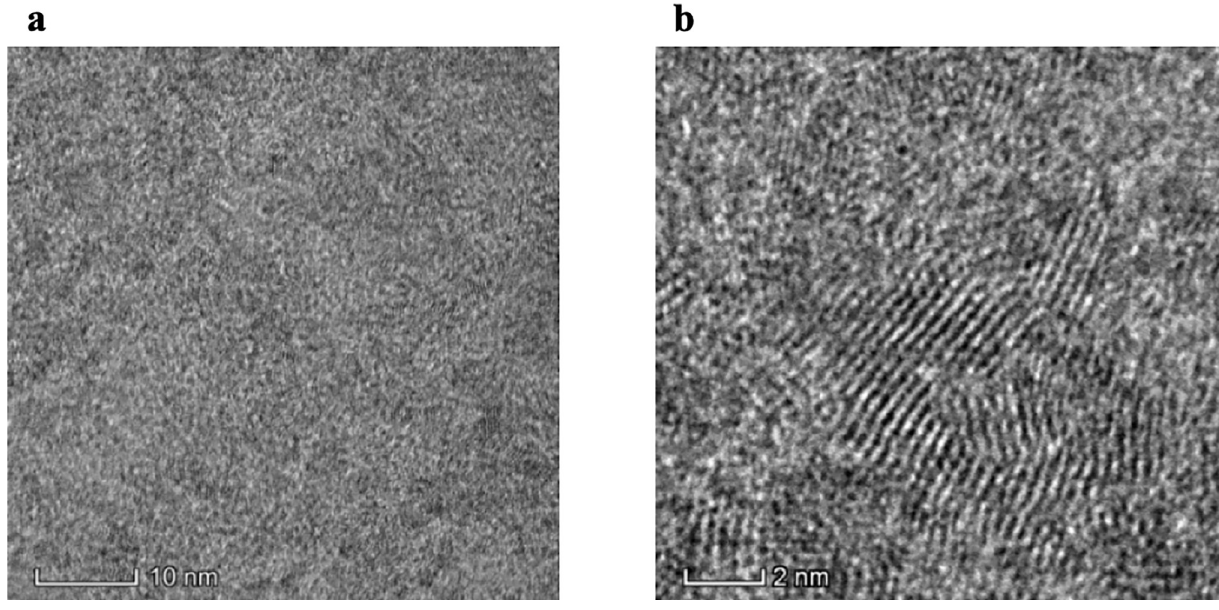
Fig 3. TEM (a) and HRTEM (b) images of CdTe QDs.